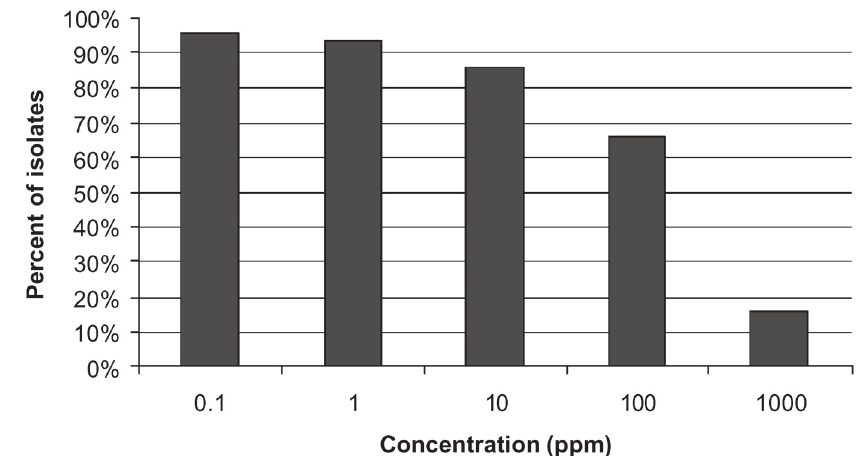
Fig. 2. Percent of isolates of Alternaria solani that grew in vitro at various concentrations of